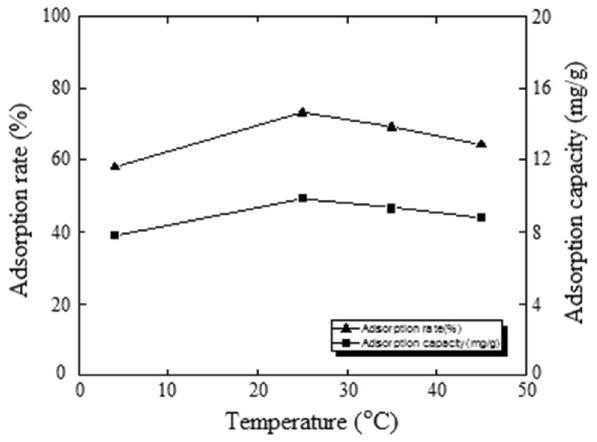
Fig. 7 Effect of temperature on cadmium adsorption; m(SBA- Fig. 8 Effect of the initial concentration of cadmium(II on adsorption C 15) = 0.10 g, t = 40 min, pH = 5.0, result; pH = 5.0, m(SBA-15) = 0.10 g, t = 40 min, T = 25 Cd 2 + = 1.0 mg/mL